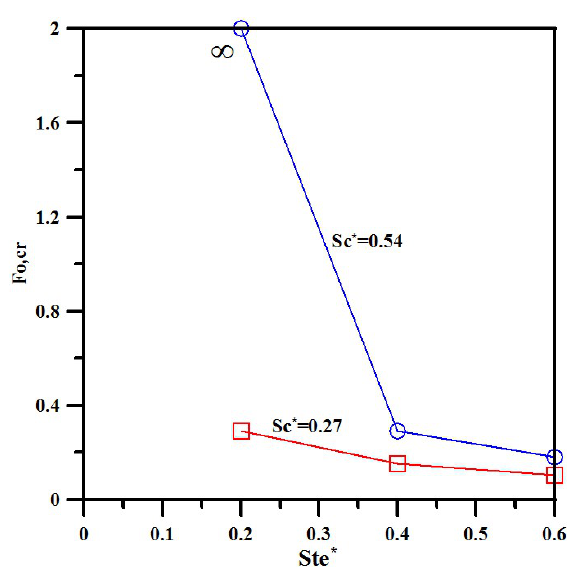
Figure 5. Relation between Fo,cr with Ste* and Sc* under constant temperature boundary conditions.